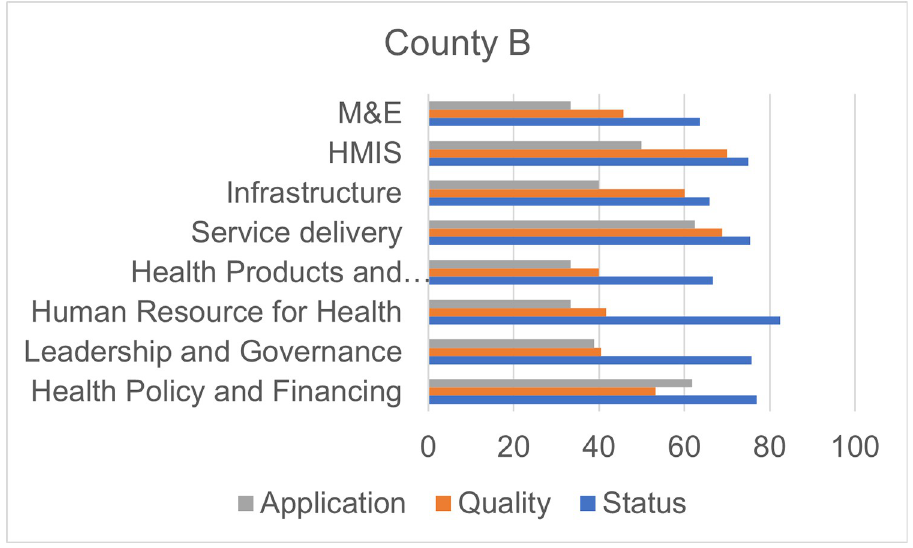
Fig 2. Scores by dimension of assessment, County B.